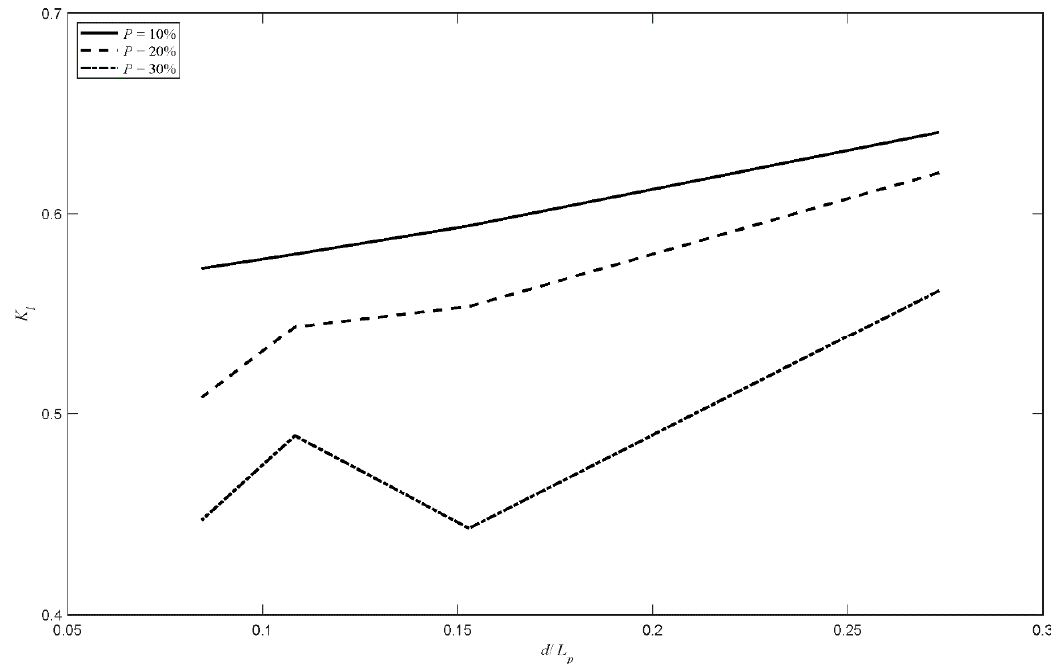
= 1, θ = 90 ◦ , and H l for N